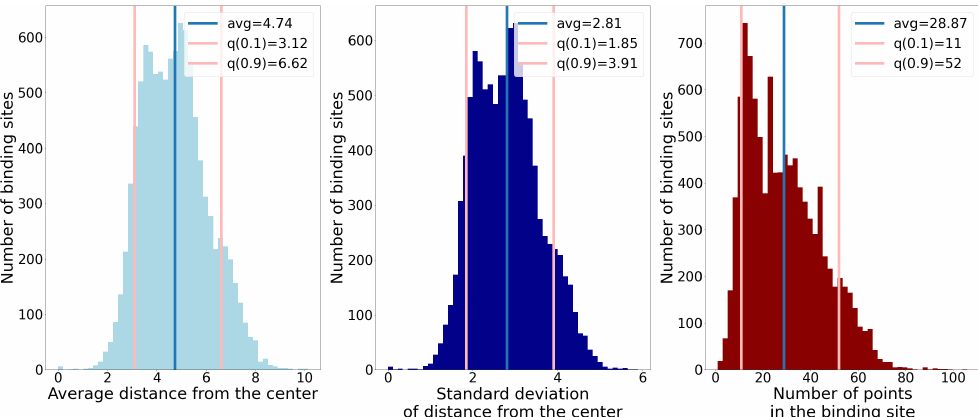
Figure 6. Histograms of three different properties of binding sites. The blue lines denote the average value, and the pink lines denote the 10th and 90th